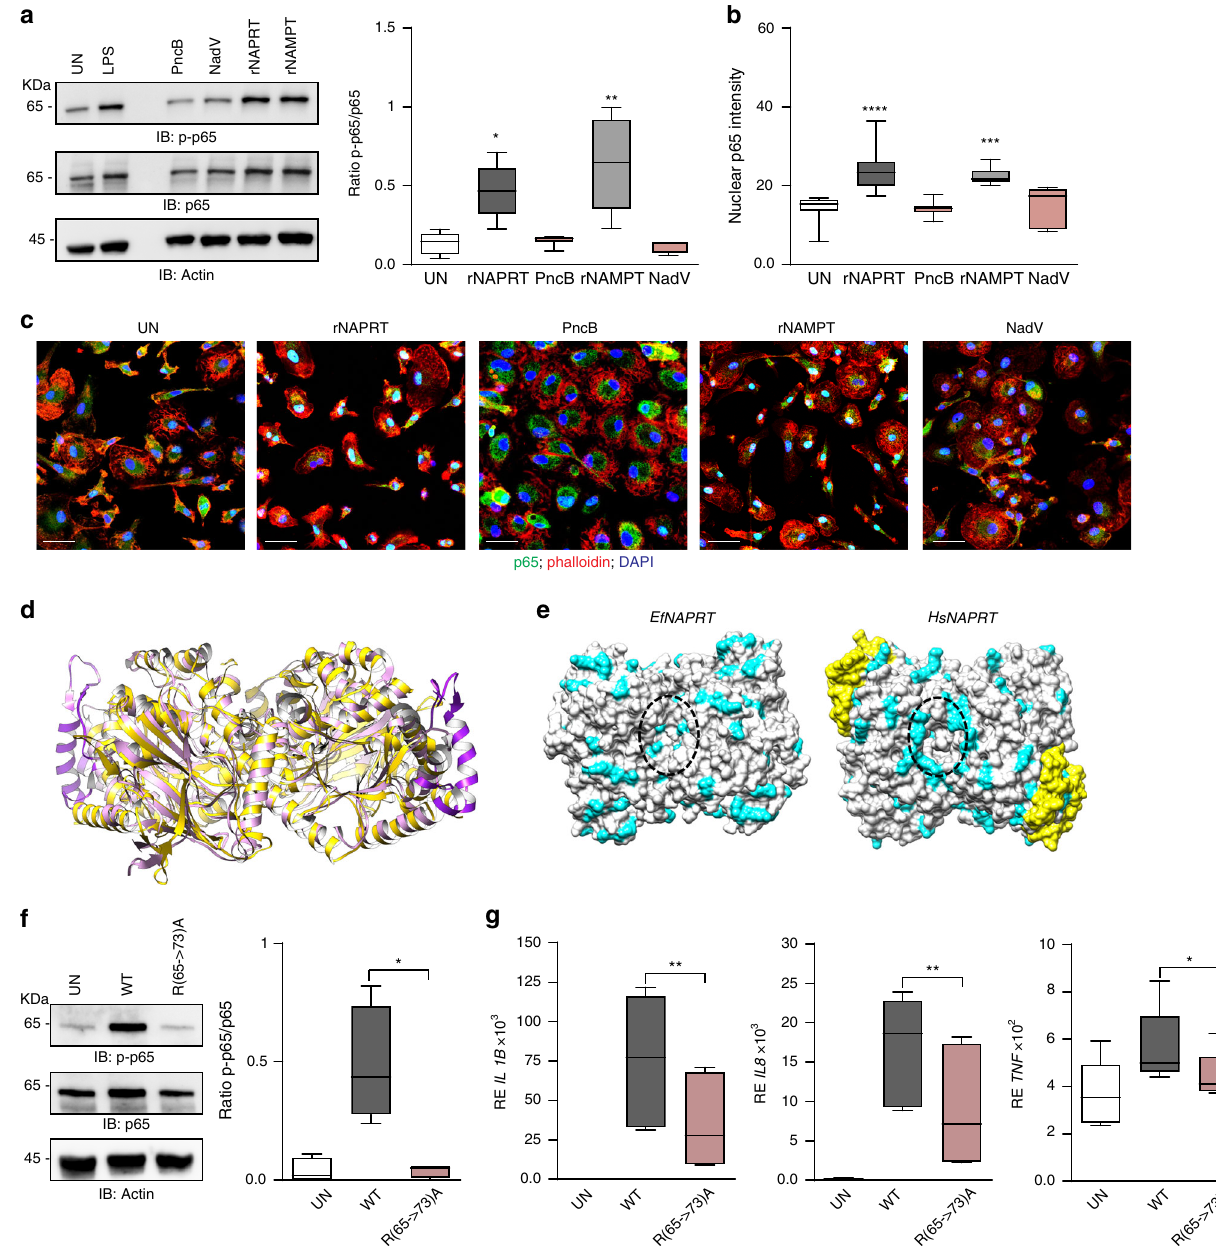
Fig. 5 Structural determinants of rNAPRT and rNAMPT involved in TLR4 binding. a Western blot analysis of p-p65 in HDs macrophages upon treatments (30 min) with rNAPRT, rNAMPT, and their bacteria ortholog, PncB ( n = 7) and NadV ( n = 4), respectively (all at 1 µ g/ml). Box plot on the right represents band quanti fi cation using ImageQuant software of p-p65/p65, Wilcoxon test. b Box plot showing relative quanti fi cation of nuclear p65 mean fl uorescence intensity in human macrophages after 30 min treatments with rNAPRT, PncB, rNAMPT, and NadV (all at 1 µ g/ml, at least n = 3, Mann – Whitney test). c Representative confocal microscopy images showing p65 localization (green fl uorescence, original magni fi cation ×63, scale bar: 25 µ m). Cells were counter-stained with Alexa568-phalloidin and DAPI. d Superposition of dimeric human ( Hs ) (in pink, PDB: 4YUB) and E. faecalis ( Ef , in gold, PDB: 4MZY) NAPRT in ribbon representation. The 46 amino acids insertion of Hs NAPRT is highlighted in magenta. e The protein surfaces (top view) of Hs NAPRT (PDB ID: 4YUB) and Ef NAPRT (PDB ID: 4MZY) dimers are colored in white. The positively charged amino acids lysine and arginine are colored in cyan. The 46 amino-acid insertion of Hs NAPRT is highlighted in yellow. The mouth-shaped areas of the two enzymes are contoured by a dotted oval. f Western blot analysis of p-p65 in HDs macrophages upon treatments (30 min at 1 µ g/ml) with wt rNAPRT and R(65->73)A NAPRT mutant ( n = 4). On the left, box plots represent band quanti fi cation using ImageQuant software of p-p65/p65, paired t -test. g Box plots showing mRNA expression levels of IL1B, IL8, and TNFA evaluated by qRT-PCR in RNA from HD macrophages ( n = 8) treated with wt rNAPRT (1 µ g/ml) and R(65->73)A NAPRT mutant (1 µ g/ml) for 15 h, paired t -test. Results are reported as box plots, where the line in the box de fi nes the median and the error bars de fi ne the minimum and maximum of all data. Source data are provided as a Source Data fi